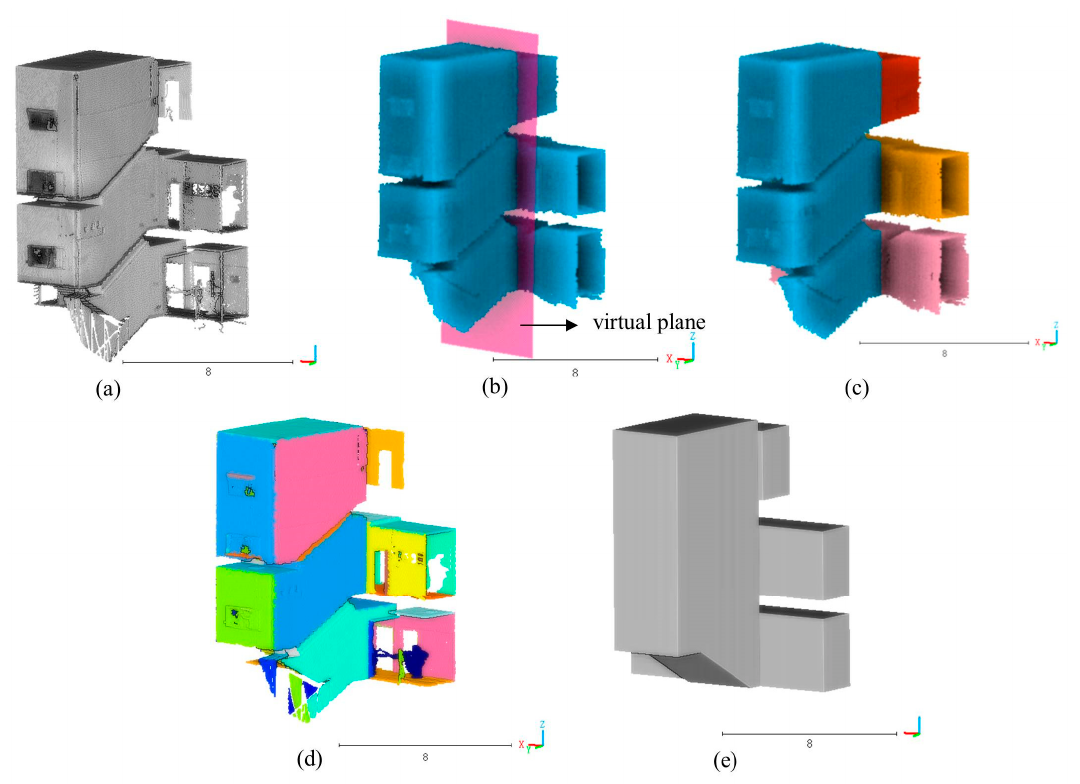
Figure 11. ( a ) Original point cloud; ( b ) initial room segmentation result; ( c ) further division into three corridors and a stair space using a virtual closure plane; ( d ) segmented planes; ( e ) reconstructed room layout of cross-floor spaces.